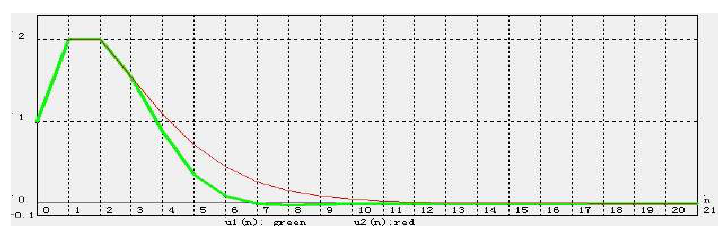
Figure 1. Convergence of { u n } in (28) (denoted by { u 1 ( n ) } ) and { u n } in (29) (denoted by { u 2 ( n ) }